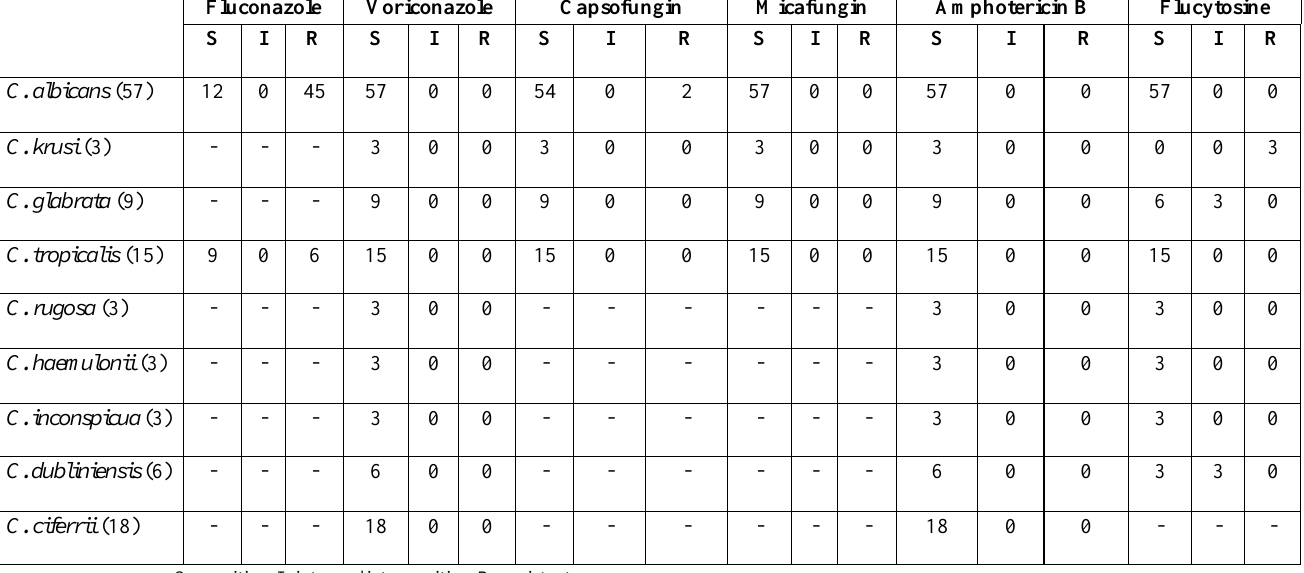
Table 3. Antifungal susceptibility testing of Candida isolates as measured by Vitek 2 automated yeast identification system (YST cards).